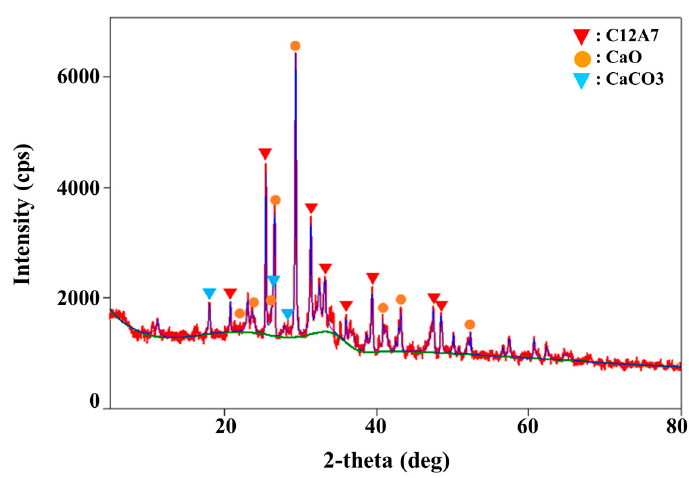
Figure 6. XRD results for WPSA.